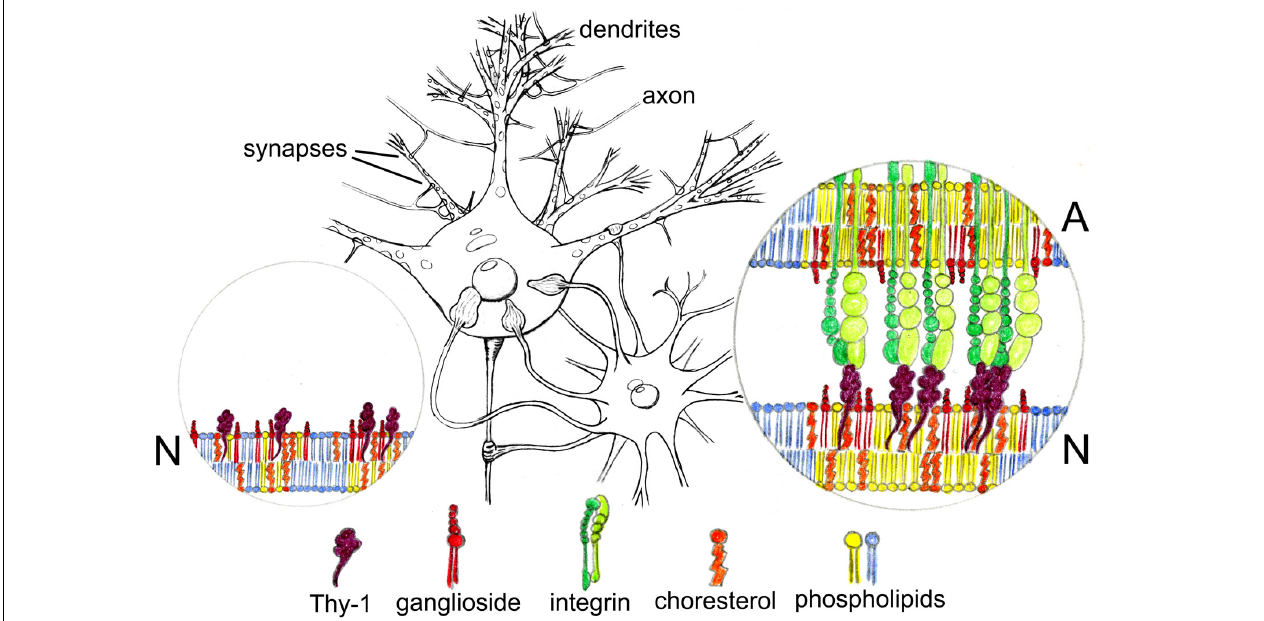
FIGURE 4 | Hypothetical participation of gangliosides in the nanoclustering of neuronal Thy-1 induced by astroglial α v β 3 integrin. Soma, axon, and dendrites of one neuron are contacted by end feet of one astrocyte ( middle drawing ). We propose gangliosides could be important for correct positioning and signaling functions of Thy-1 in rafts in the plasma membrane of neurons. If this turns out to be true, then, gangliosides should influence the diffusion and clustering properties of Thy-1 along the neuronal surface ( N, left circle ) as well as the clustering of Thy-1 molecules induced by α v β 3 integrin expressed by astrocytes ( A, right circle ). α v β 3 integrin-bound Thy-1 might be integrated in nanodomains with particular ganglioside composition to initiate signaling which may differently impact the functioning of each cell